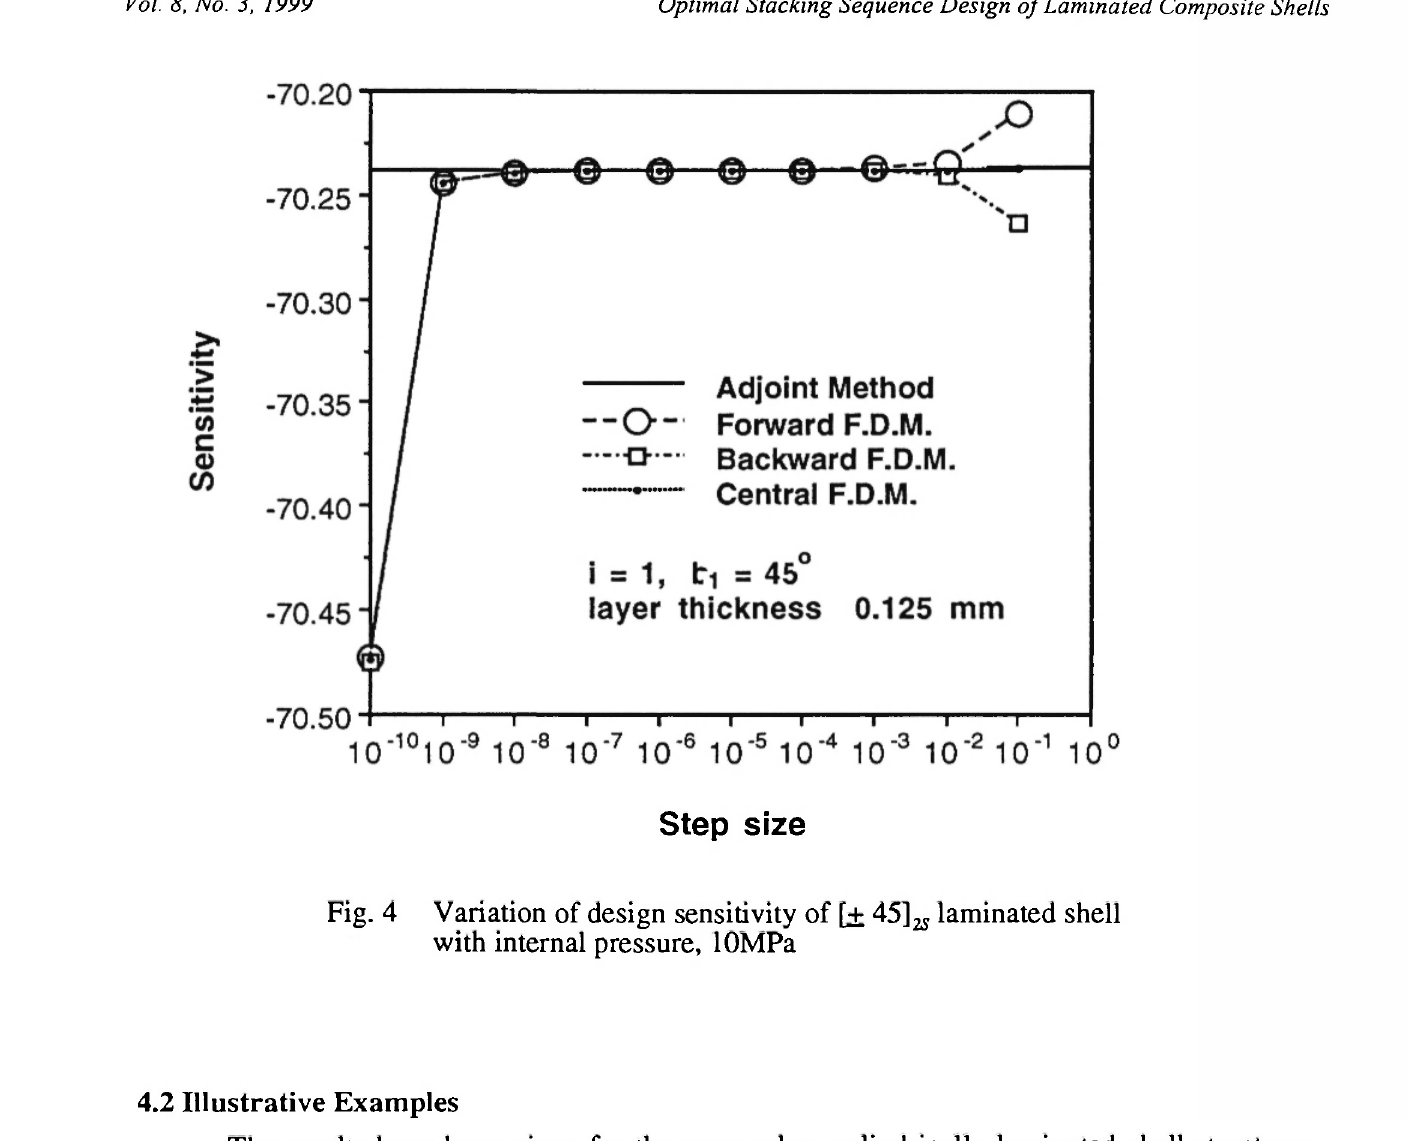
Step size Fig. 4 Variation of design sensitivity of [± 45] laminated shell M with internal pressure,